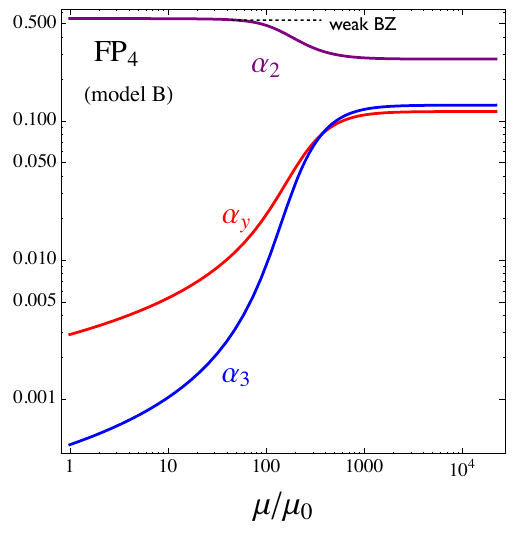
Figure 8 . Shown is the running of the gauge and BSM Yukawa couplings along the UV-IR con- necting separatrix emanating from FP 4 for the benchmark model B , (4.19). The scale (cid:22) 0 may take any value determined by the free parameter (cid:14)(cid:11) 3 ((cid:3)). The weak gauge coupling is attracted towards its \would-be" Banks-Zaks (cid:12)xed point (weak BZ) , see (A.10), indicated by the dashed line. Consequently, the interacting UV (cid:12)xed point cannot be matched onto the